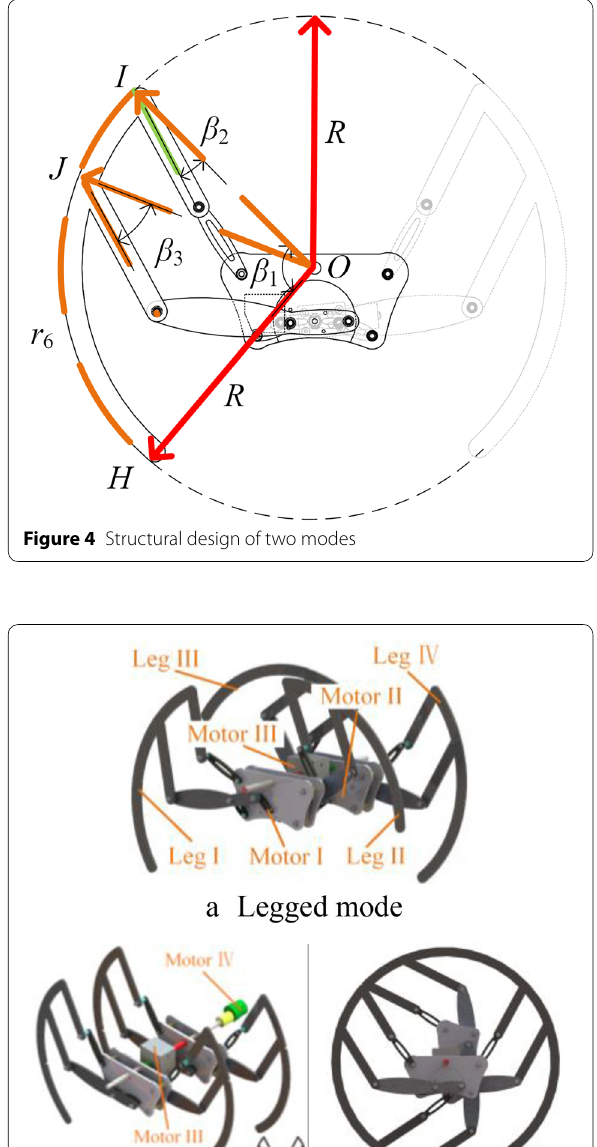
Figure 5 Conversion process between two modes